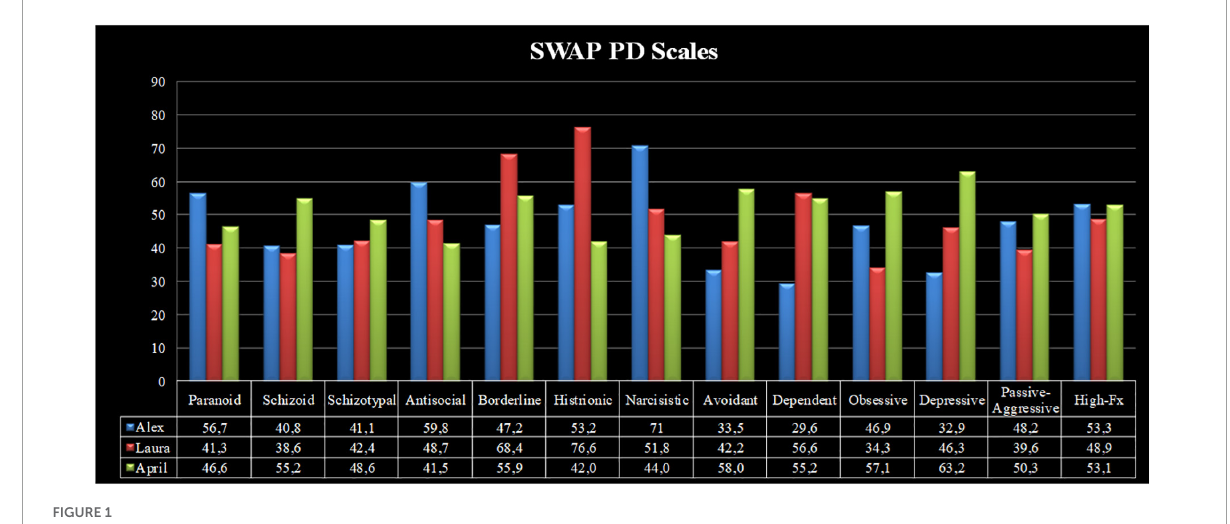
FIGURE1 SWAP-200 personality profiles of Alex, Laura, and April.